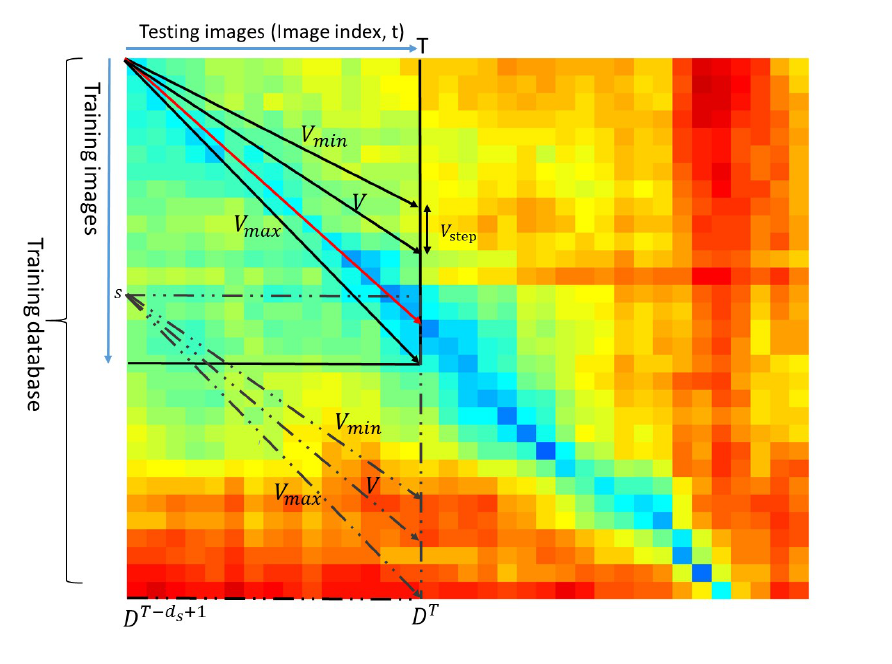
Figure 3. The search algorithm finds the lowest-cost straight line within the searching matrix M T . These lines are the set of potential paths through the matrix. The red line is the lowest-cost path which aligns the testing sequence and the training sequence. Each element represents the cosine distance between two